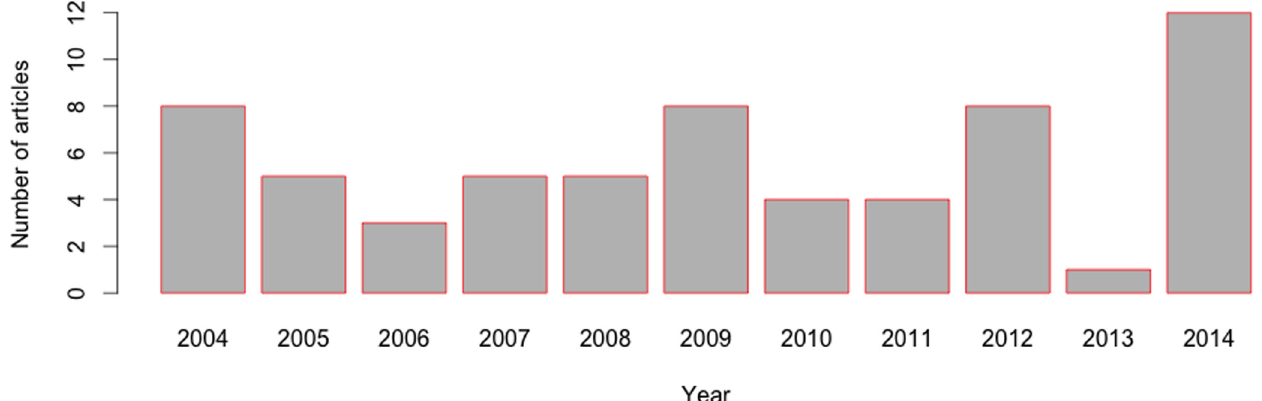
Fig 1. Bioinformatics-related publications authored by scientists affiliated with Ghanaian institutions. As a measure of bioinformatics research output in Ghana, the search terms “ next-generation sequencing Ghana, ” “ computational biology Ghana, ” “ bioinformatics Ghana, ” “ genomic Ghana, ” and “ in silico Ghana ” were used to obtain peer-reviewed research articles published between 2004 and 2014 and indexed in the PubMed, Web of Science, and SCOPUS databases (refer to the main text for article inclusion criteria).